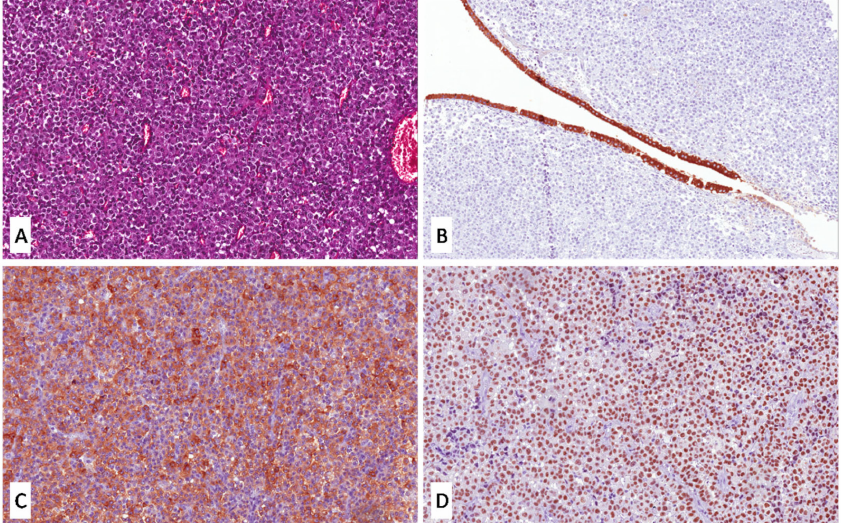
Figure 1. ( A ) High magnification shows a hypercellular and slightly pigmented tumor composed of epithelioid cells with large polygonal eosinophilic cytoplasm and vesicular nuclei with prominent nucleoli (H&E; original magnification 200 × ); ( B ) a thin flap of overlying atrophic gallbladder mucosa, immunoreactive for pancytokeratins, compressed by the tumor, is seen (immunoperoxidase; original magnification 200 × ); ( C , D ) neoplastic cells are diffusely and strongly positive for Melan-A ( C ) and SOX10 ( D ) (immunoperoxidase; original magnifications 200 ×